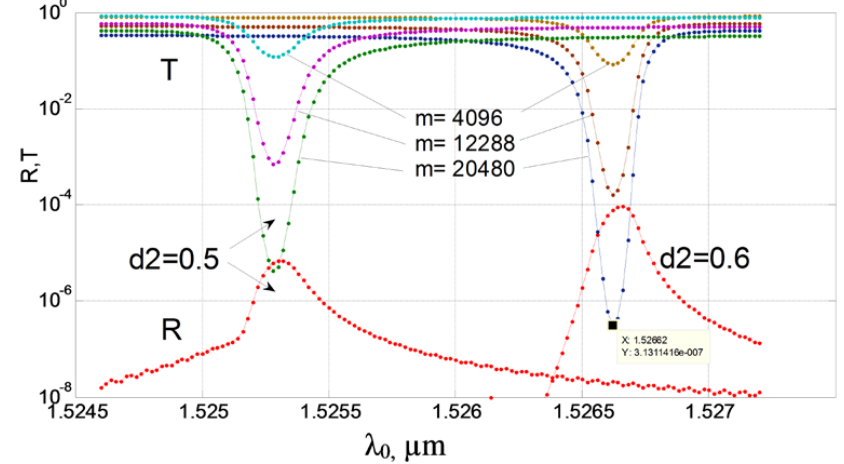
Figure 19. The effect of abnormal blocking for the backward diffraction. The dependence of the transmission power and reflection of the fundamental mode of the silicon wire on the wavelength for different number of segments ( M = 4096, 12,288 and 20,480). Two operating wavelengths λ 0 = 1.52528 µm and 1.52662 µm for the inclined segment boundary ( d 2 = 0.5 µm) and the vertical segment boundary ( d 2 = d 1 = 0.6 µm), respectively. The evanescent gap d = 0.25 µm, the thickness of the polymer H = 1.25 µm, 1.2 µm period. Analysis made using 2D MoL plus EIM.